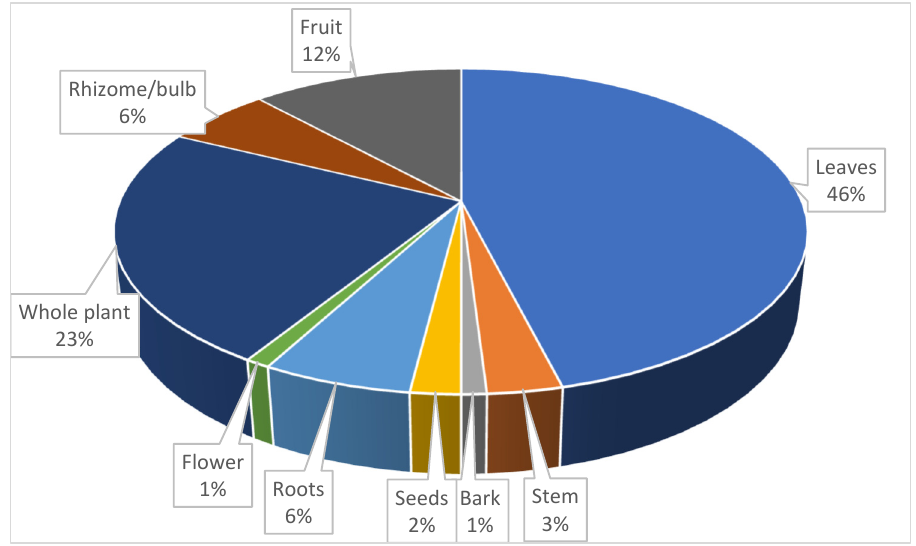
Figure 2. Distribution of plant parts used by the subsistence farmers in mitigating cabbage and spinach diseases in OR Tambo Municipality, South Africa, (n = 103).